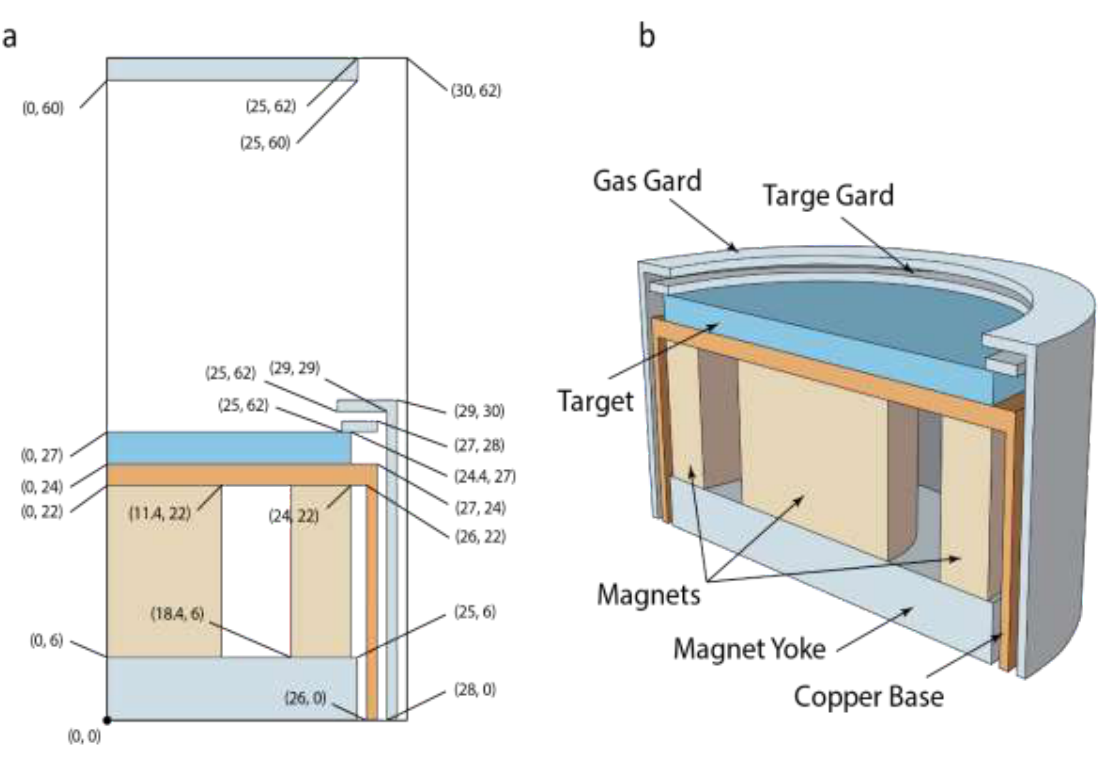
Figure 1: a) Schematic diagram of the magnetron source used in the simulation. All dimensions are in mm. b) cross-section of the 3D design of the magnetron source showing the target and the